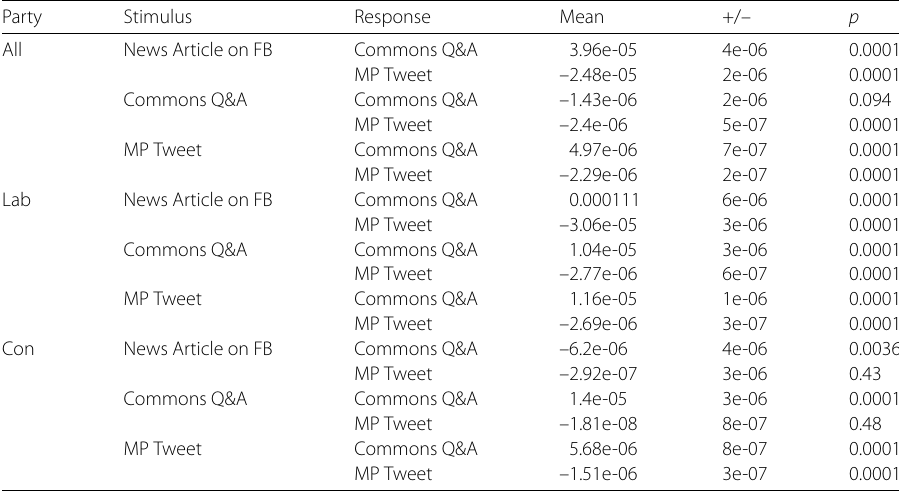
Table 1 Overall mean content flows between domains. Error bars and p -values were obtained by bootstrapping with 10 4 resamples. FB stands for Facebook Party Stimulus Response Mean +/– p All News Article on FB Commons Q&A 3.96e-05 4e-06 0.0001 MP